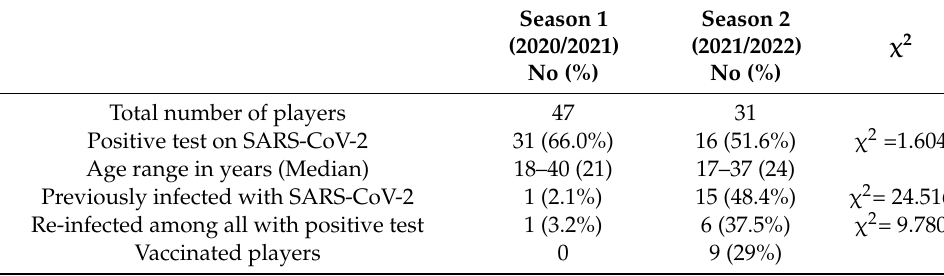
Table 1. Distribution and characteristics of